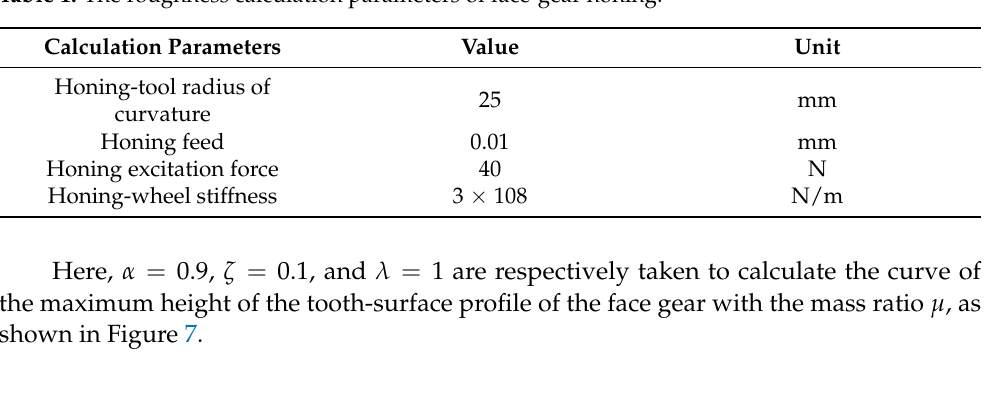
Table 1. The roughness calculation parameters of face-gear